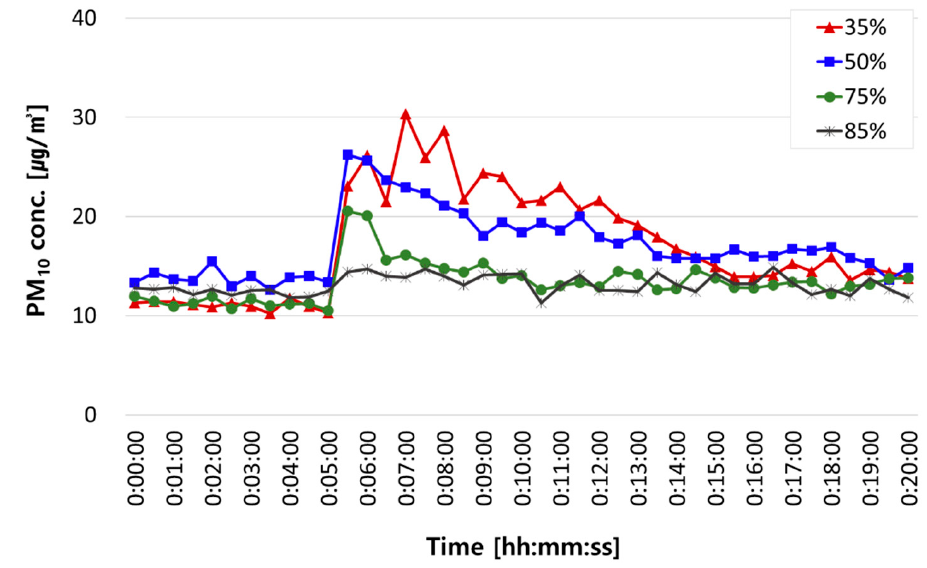
Figure 5. Changes in PM 10 concentrations in the classroom chamber under each humidity condition: at 35%, 55%, 75%, and 85% humidity.